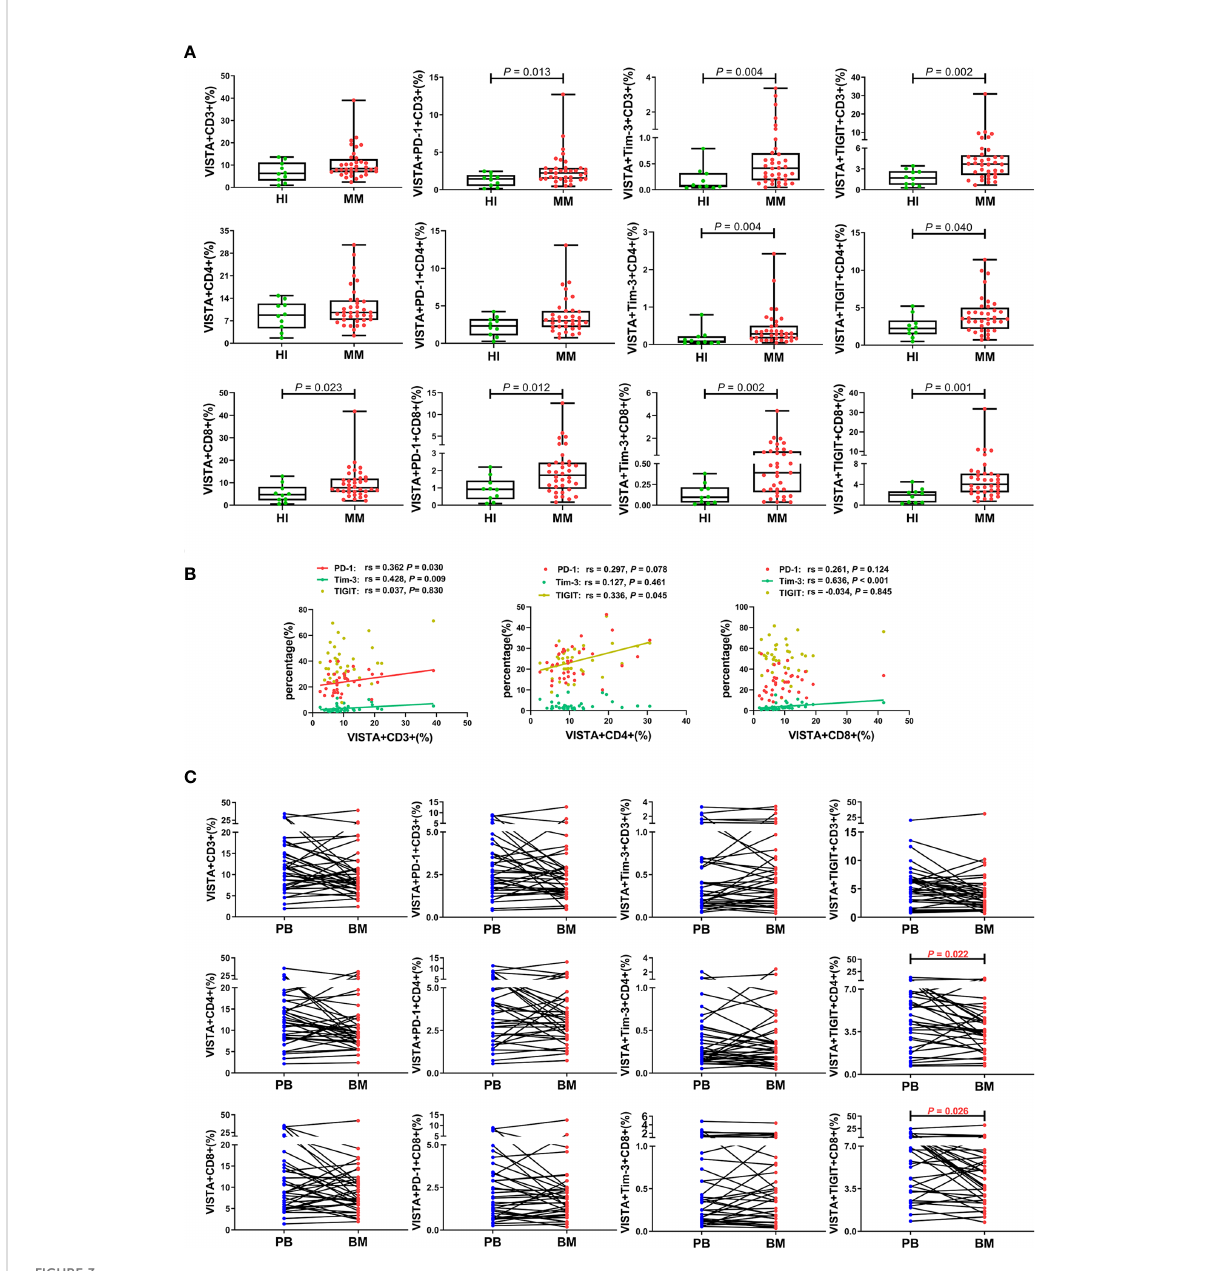
FIGURE 3 Distribution and frequency of VISTA expression and co-expression with PD-1, Tim-3, and TIGIT on T cell subsets in BM from MM patients. (A) Comparison of the frequency of VISTA expression and co-expression with PD-1, Tim-3, and TIGIT on the CD3+, CD4+, and CD8+ T cell subsets in patients with MM and healthy individuals. (B) Correlation between the percentages of VISTA+ and PD-1+, Tim-3+, and TIGIT+ T cells on T cell subsets from MM patients. (C) Comparison of the percentage of VISTA+, VISTA+PD-1+, VISTA+Tim-3+, and VISTA+TIGIT+ T cells on T cell subsets between PB and BM from 36 patients with